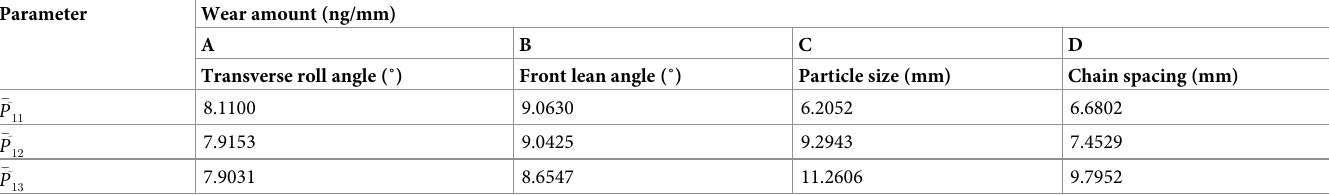
Table 12. Wear amount of the middle trough in the validation experiment.